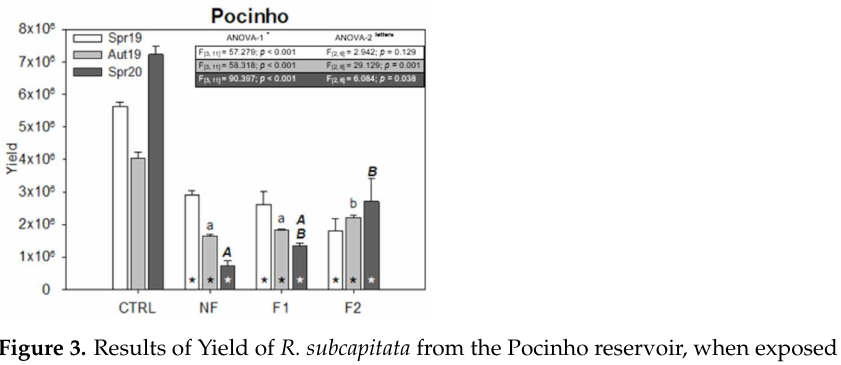
Figure 3. Results of Yield of R. subcapitata from the Pocinho reservoir, when exposed to treatments: control (CTRL) and natural water treatments (NF—Non-filtered water; F1 and F2—filtered with 1.2 µ m and 0.22 µ m respectively). Data are stated as mean ± standard error (SE); n = 3. * Stands for significant differences detected by Dunnett test. Different letters (a, b for Aut19 and A , B for Spr20) stands for significant differences between treatments, detected by Tukey